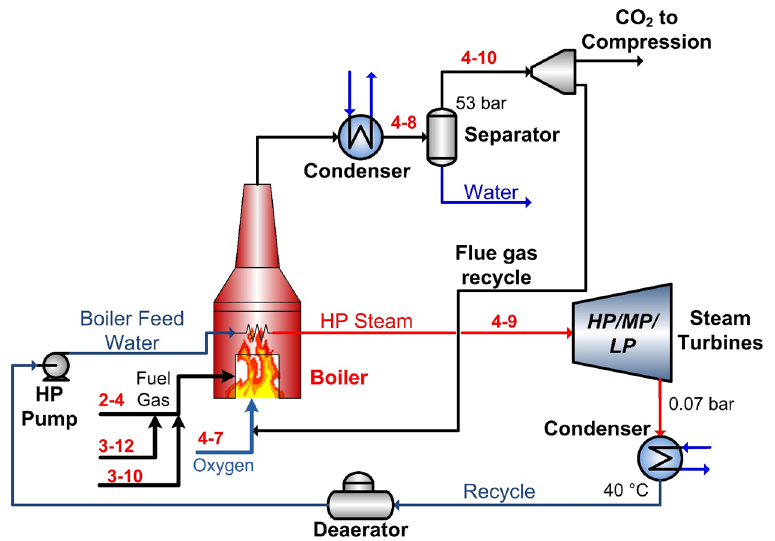
Figure 6. Section 4 Option 2: Power generation with oxy-fuel